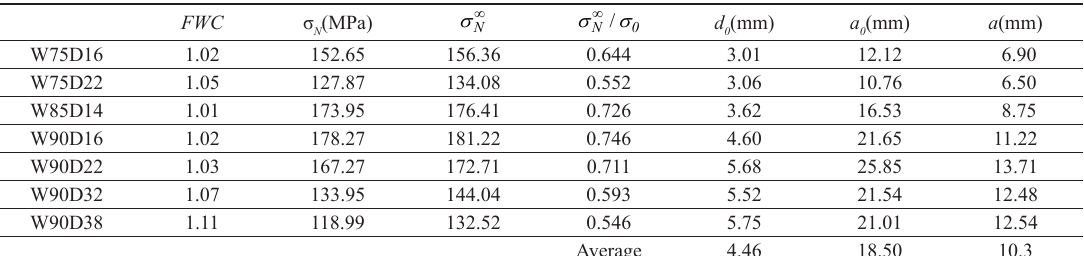
Table 3. Experimental data of the material with a hole and characteristic lengths d